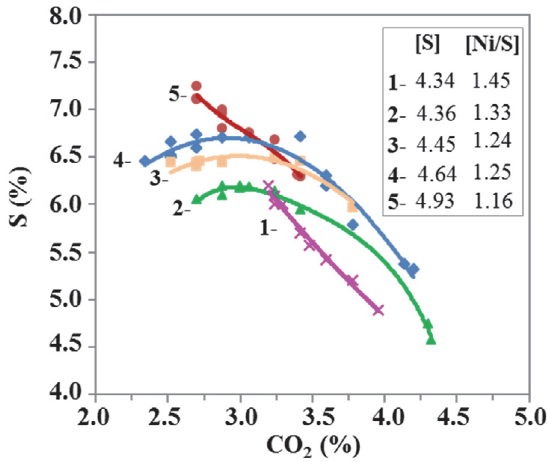
Figure 7. Interaction between sulfur and carbon dioxide in the Ba- sic Nickel Carbonate , industrial process (Stage 03). The [S] concen- tration (g∙L –1 ) and the [Ni/S] ratio in the Product-liquor can be ap- preciated. 1.60 ≤ NH 3 /CO 2 < 1.80.